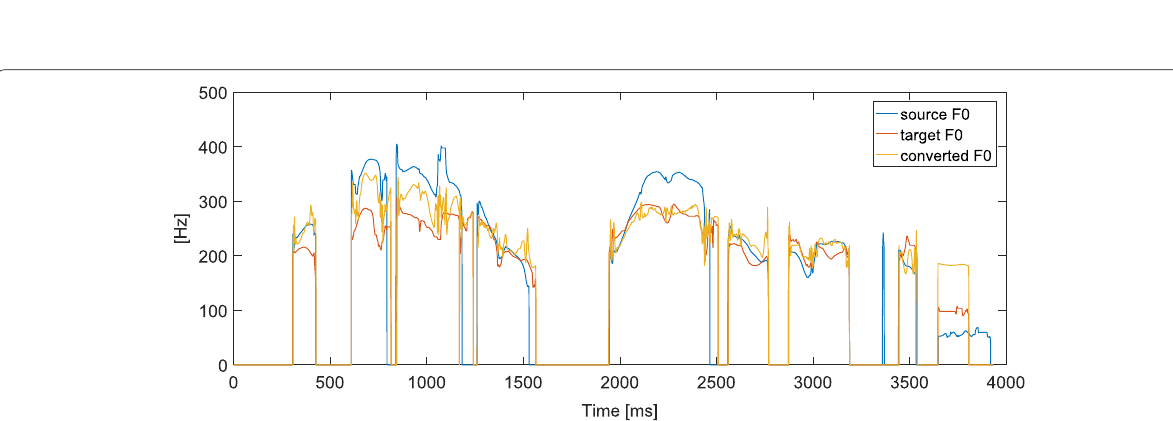
Fig. 13 Examples of source F0, target F0, and converted F0